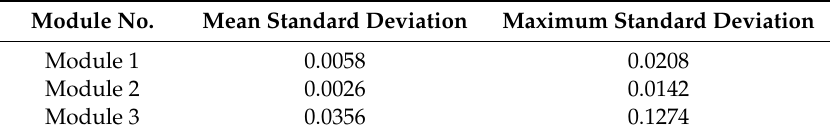
Table 6. SOC standard deviation of cells in modules under NEDC working conditions.